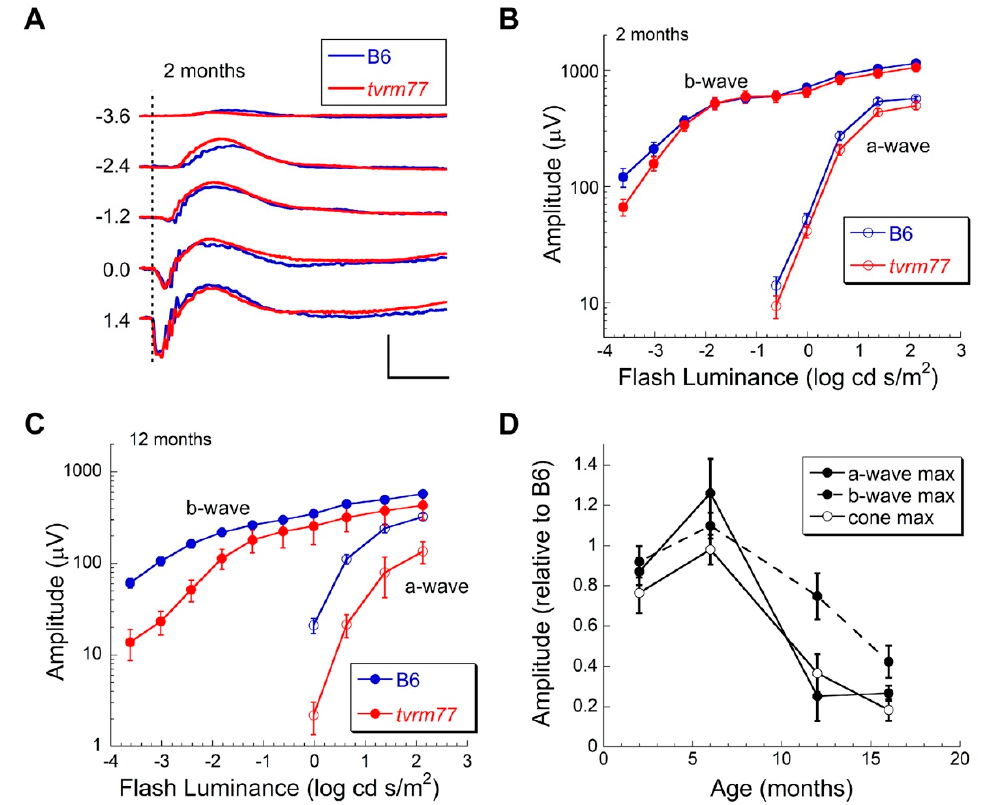
Figure 7. Strobe flash ERG analysis of B6 and tvrm77 mice. ( A ) Representative ERGs obtained from 2-month-old B6 (blue) and tvrm77 (red) mice exposed to strobe flash stimuli in log cd s m − 2 presented to the dark-adapted eye. Calibration bars indicate 100 msec and 500 µV. ( B ) Luminance–response functions for the major components of the ERG obtained from 2-month-old mice. Data points indicate the mean (±SEM) response amplitude of six B6 and six tvrm77 mice. ( C ) Luminance–response functions for the major components of the ERG obtained from 12-month-old mice. Data points indicate the mean (±SEM) response amplitude of five B6 and five tvrm77 mice. ( D ) Response amplitudes of tvrm77 mice plotted relative to B6 controls as a function of age. Responses of tvrm77 mice were comparable to those of B6 mice up to 6 months of age and declined at older ages. Data points indicate mean (±) SEM of 3–15 mice.